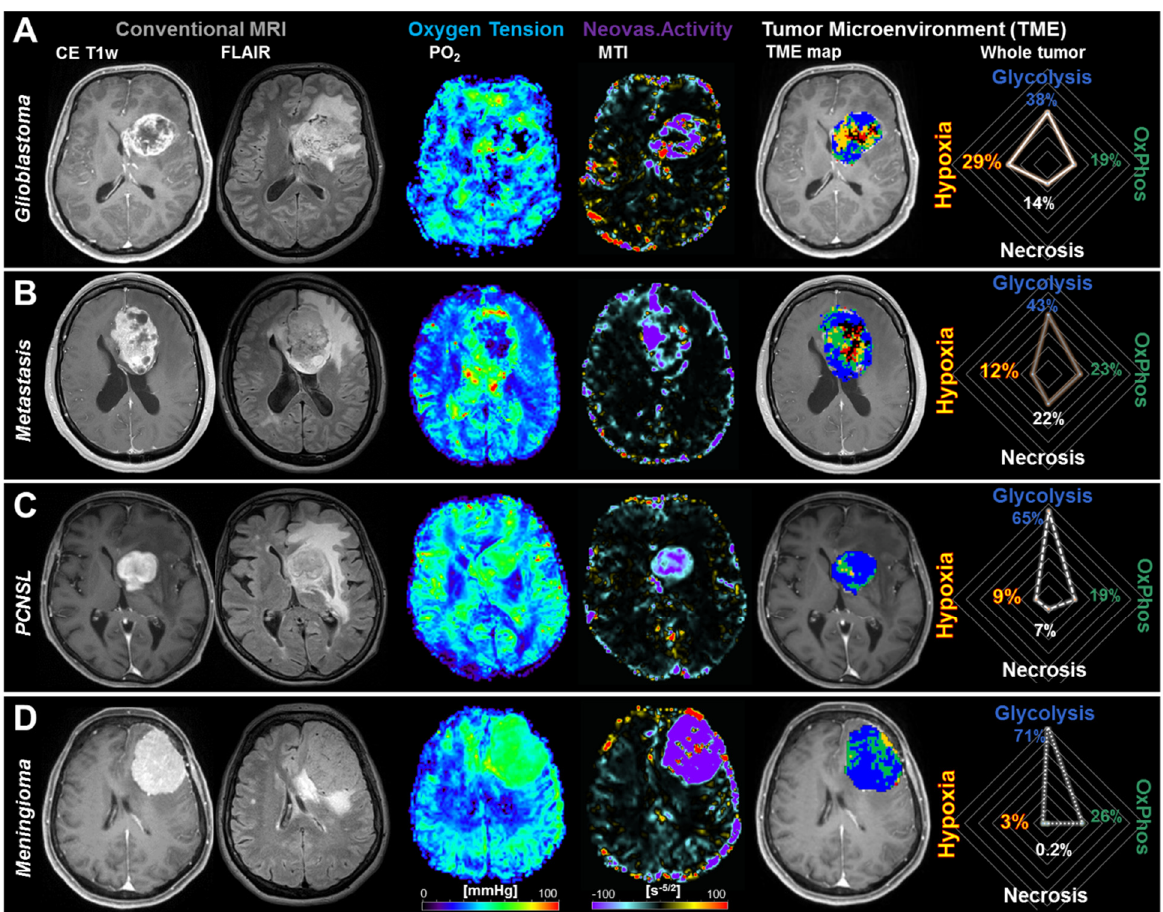
Figure 1. Tumor microenvironment (TME) mapping of patients with contrast-enhancing brain tumors. Conventional, anatomical MRI, tissue oxygen tension (PO 2 ), neovascularization activity represented by MTI (microvessel type indicator), as well as the corresponding TME map and the distribution of the TME compartments for the whole tumor as radar chart for a patient with ( A ) glioblastoma WHO grade 4, IDH-wildtype; ( B ) a brain metastasis from breast cancer; ( C ) primary central nervous system (CNS) lymphoma (PCNSL); and ( D ) meningioma, respectively. Color code in the TME maps: blue = glycolysis, green = oxidative phosphorylation (OxPhos), black = necrosis, yellow and red = hypoxia with and without neovascularization, respectively. Note: hypoxia in the radar chart is the sum of hypoxia with neovascularization and hypoxia without neovascularization.